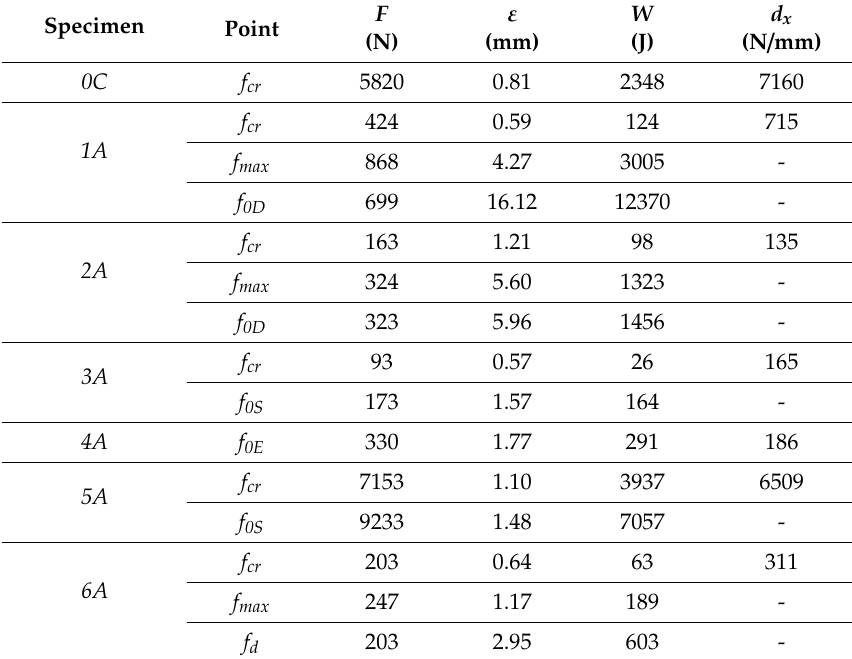
Table 3. Presentation of the results (characteristic points on the force–deformation curve) for the reference specimen 0C and tested resins 1A, 2A, 3A, 4A, 5A, 6A.